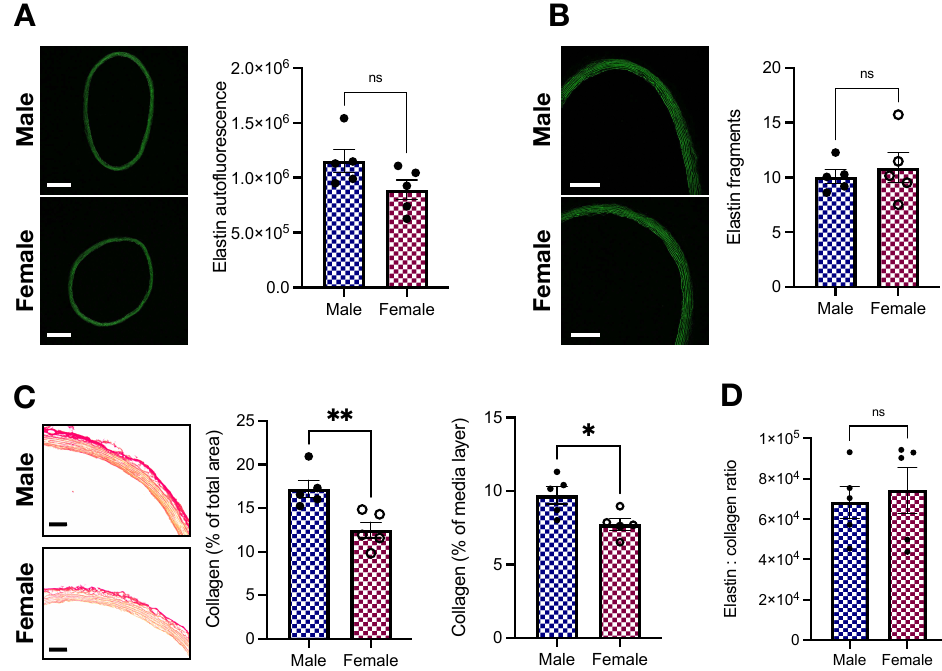
Figure 5. Female Wistar rats have lower levels of collagen without changes in elastin contents. ( A ) Elastin autofluorescence (arbitrary units), ( B ) elastin fragments (units), ( C ) collagen (picrosirius red), and ( D ) elastin:collagen ratio. Data are presented as means ± SEM, n = 5. * p < 0.05, ** p < 0.01, and ns. p > 0.05. Scale bars: 500 µ m ( A ), 250 µ m ( B ), and 100 µ m ( C